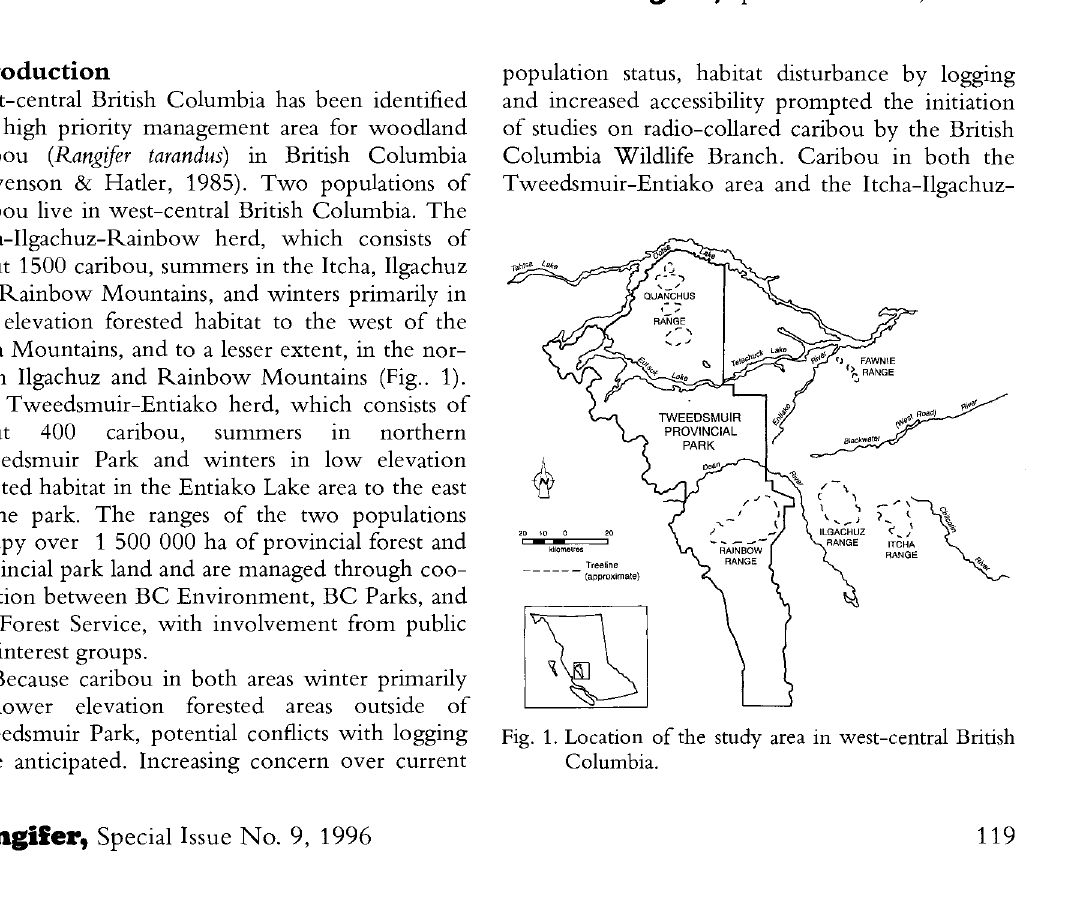
Fig. 1. Location of the study area in west-central British